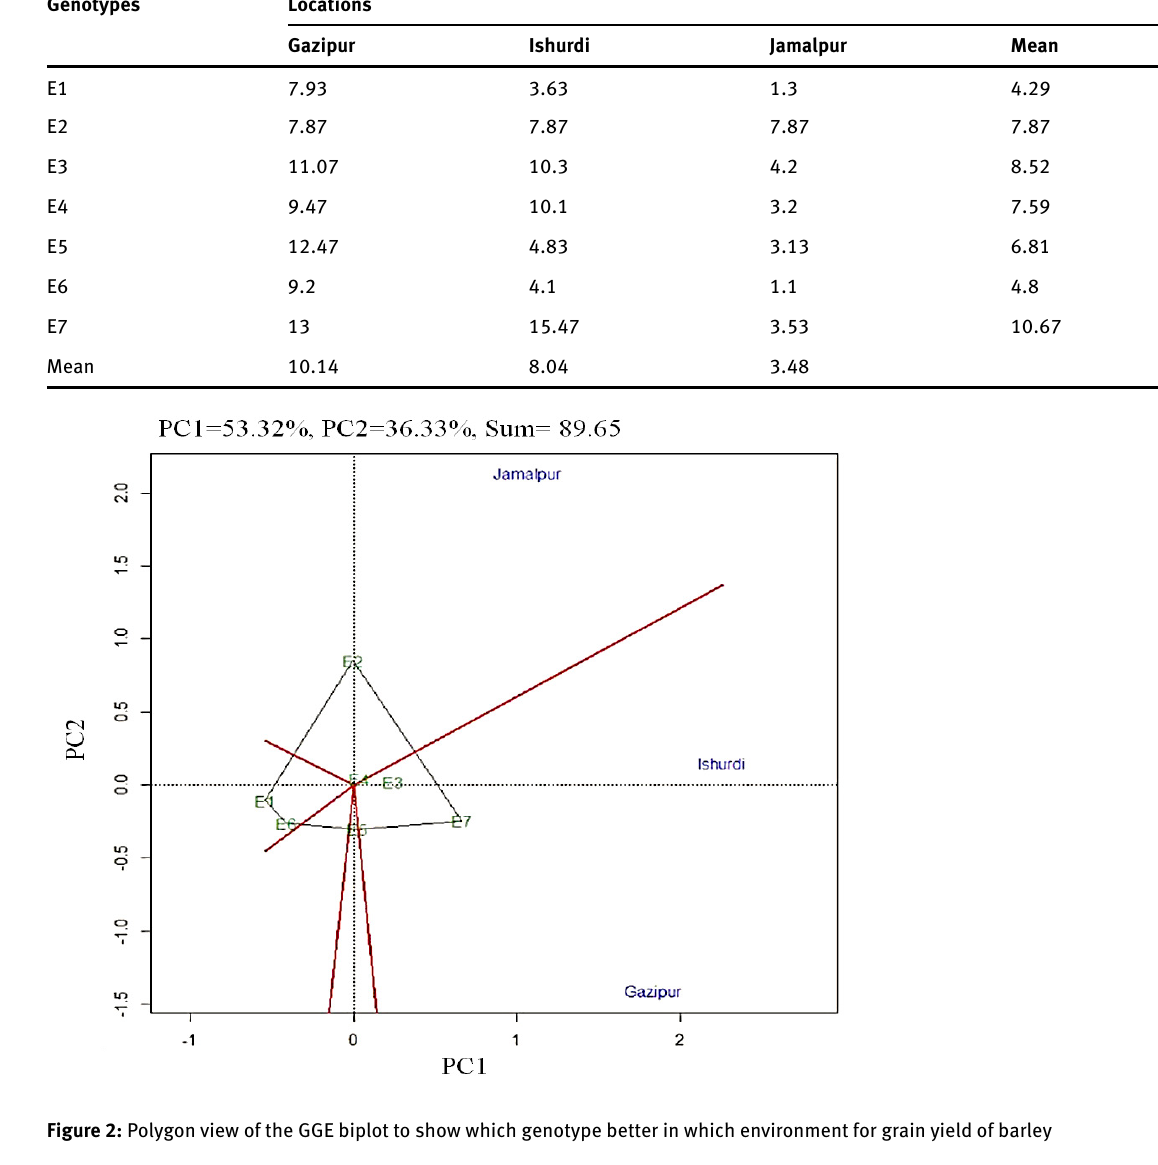
Table 3: Mean grain yield (t ha -1 ) of seven barley genotypes tested across three environments Genotypes